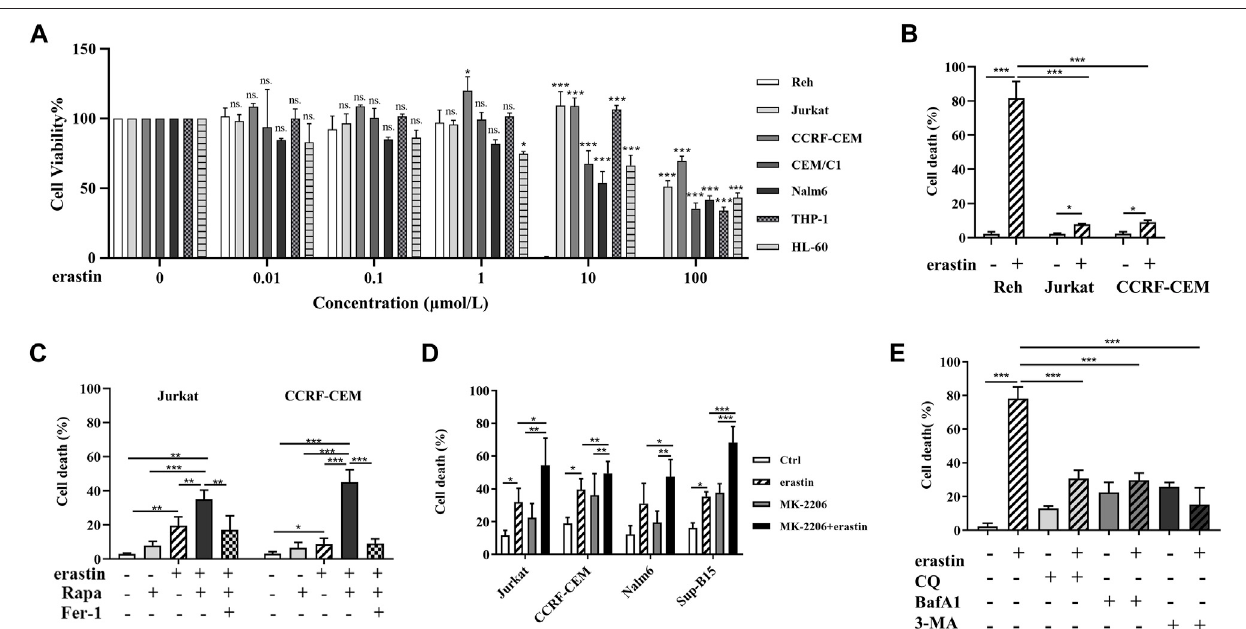
FIGURE1| Erastindecreased cellviabilityand autophagic activity regulated erastin-inducedferroptosis inALL cells. (A) ALL cellswere treatedwith0,0.01, 0.1, 1, 10, and 100 μ mol/l erastin for 24 h. The viability of ALL cells was measured via the MTS assay. (B) ALL cells were treated with erastin (20 μ mol/l) for 24 h, trypan blue staining to evaluate cell death. (C) Jurkat cells and CCRF-CEM cells were treated with the indicated stimuli (200 nmol/l Rapa, 20 μ mol/l erastin, 4 μ mol/l fer-1, Rapa+erastin, and Rapa+erastin+fer-1) for 24 h and cell death was evaluated. (D) Jurkat, CCRF-CEM, Nalm6 and Sup-B15 cells were treated with the indicated stimuli(4 μ mol/lMK-2206,20 μ mol/lerastin,andMK-2206+erastin)for24 handcelldeathwasevaluated. (E) Rehcellsweretreatedwiththeindicatedstimuli(20 μ mol/ lerastin,20 μ mol/lCQ,4 μ mol/lBafA1, 5 mmol/l3-MA,CQ+erastin,BafA1+erastin,or3-MA+erastin)for24 hand celldeathwasevaluated.* p < 0.05,** p < 0.01,*** p <